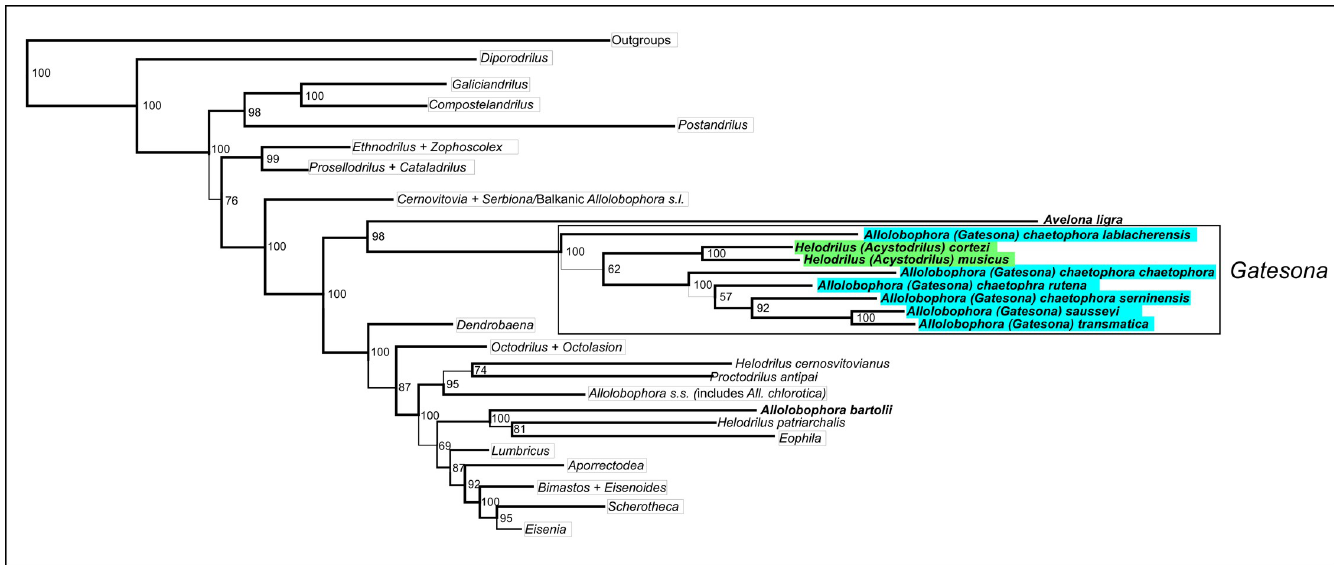
Fig 1. Detail of the phylogenetic tree obtained by Bayesian phylogenetic analysis of the concatenated sequence of molecular markers COI –16S-tRNAs– ND1 –28S (see full tree in S2 File). Allolobophora (Gatesona) representatives are shaded in blue and Helodrilus (Acystodrilus) representatives are shaded in green. Representatives of the main Lumbricidae genera were collapsed and are shown in boxes. Posterior probability support values are shown besides the corresponding nodes.